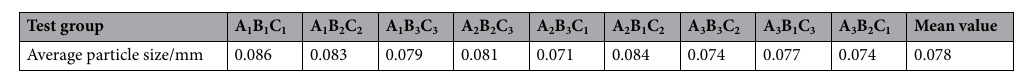
Table 11. Average particle size of SEM image of freeze–thaw orthogonal test sample.